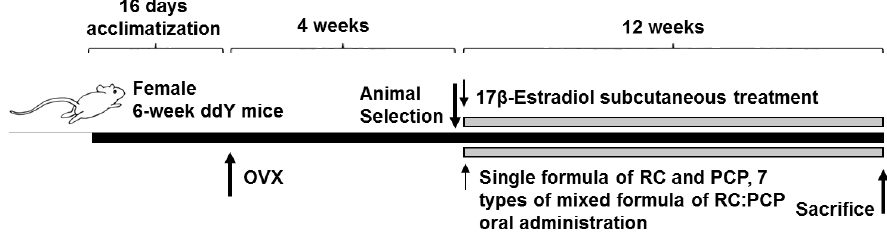
Figure 1. Experimental designs used in this study. OVX = Bilateral ovariectomy, RC = Red clover dry extracts, PCP = Pomegranate Concentrate Powder, RC:PCP = Mixed formulations consisted of RC and PCP (g/g).